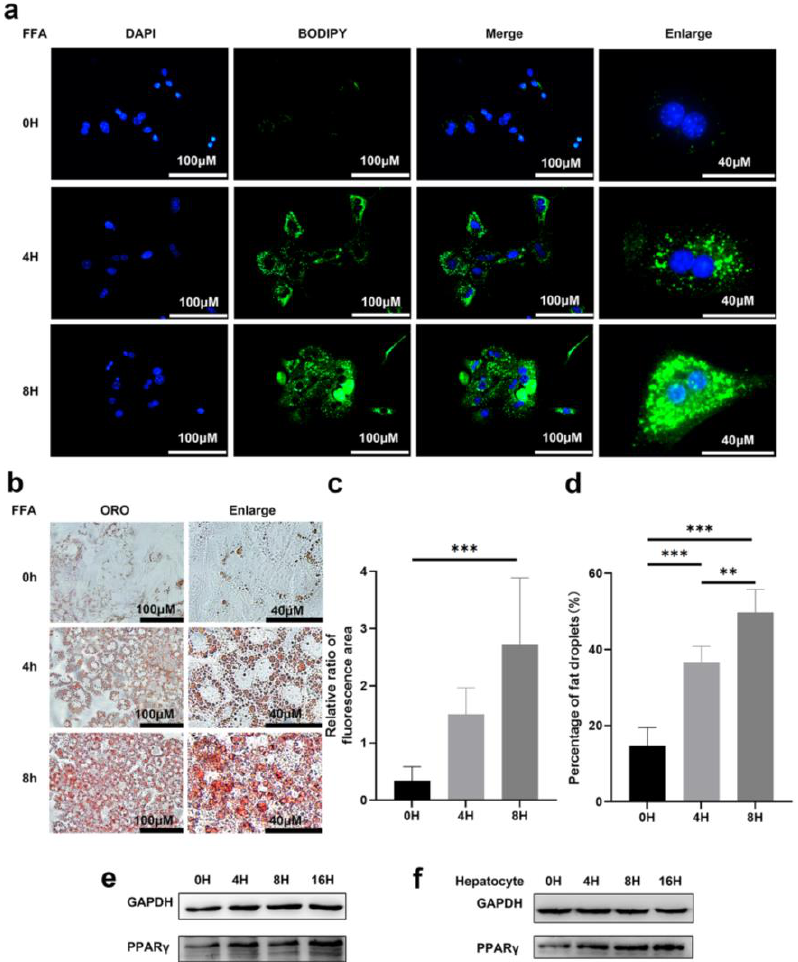
Figure 1. Lipid droplets can be induced by free fatty acid in hepatocytes. ( a ) Representative images of DAPI and BODIPY staining of primary hepatocytes treated with 1 mM FFA for indicated time. Scale bar: 40 µ M and 100 µ M. ( b ) Representative images of oil red O staining (ORO) of primary hepatocytes with indicated treatments. Scale bar: 40 µ M and 100 µ M. ( c ) Relative ratio of fluorescence area of DAPI and BODIPY staining were quantified. ( d ) Statistical analysis of area of fat droplets stained with oil red O (ORO) were presented. Huh7 cells ( e ) and primary hepatocytes ( f ) were treated with 1 mM FFA for 0, 4, 8, 16 h. Representative images of western blot showed the effects of FFA on PPAR γ expression. GAPDH was used as an invariant control. Data represents the mean ± SD, n ≥ 3. One-way ANOVA was used for statistical analysis (** p < 0.01, *** p <